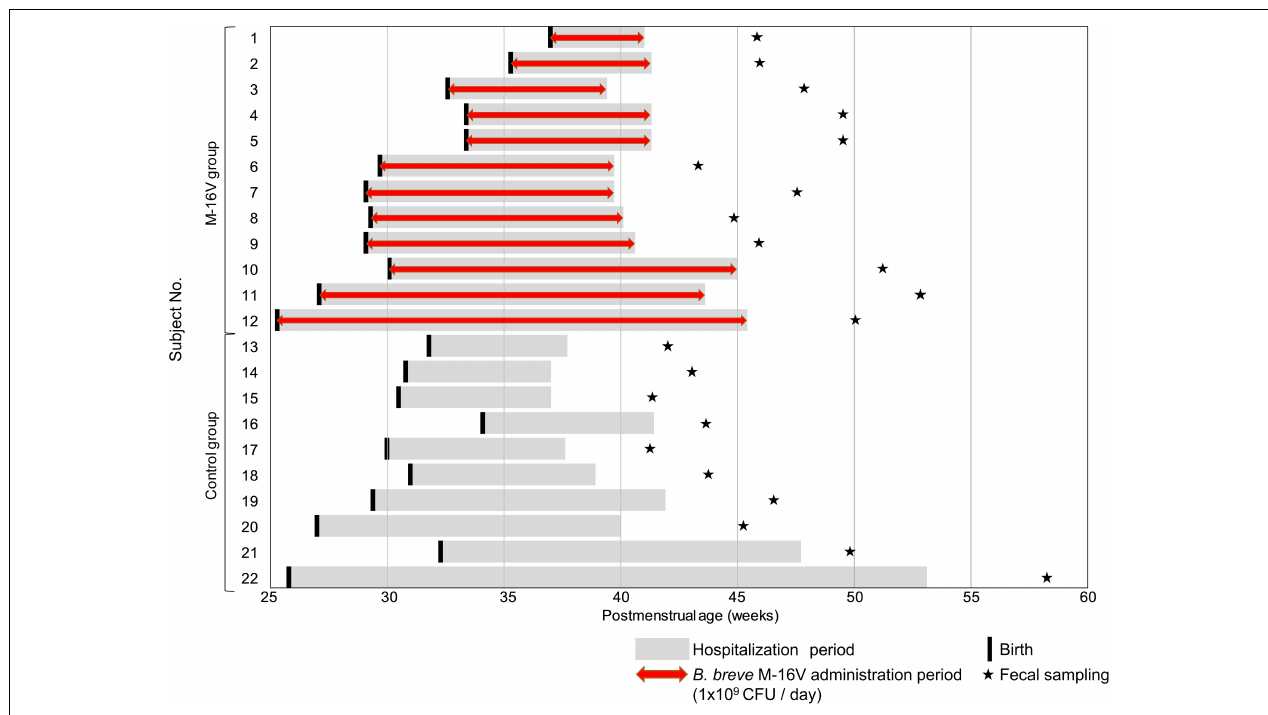
FIGURE 1 | Outline of study schedule for each subject across postmenstrual age.